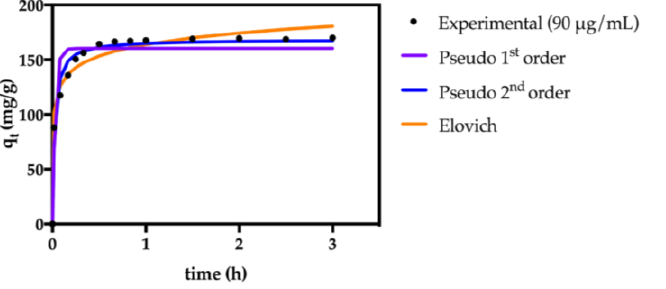
Figure 6. Modeling of adsorption kinetics of paraquat onto Fe 3 O 4 @SiO 2 /SiCRG particles using pseudo 1st and 2nd order kinetic equations and the Elovich kinetic model, for an initial paraquat concentration of 90 μg/mL.